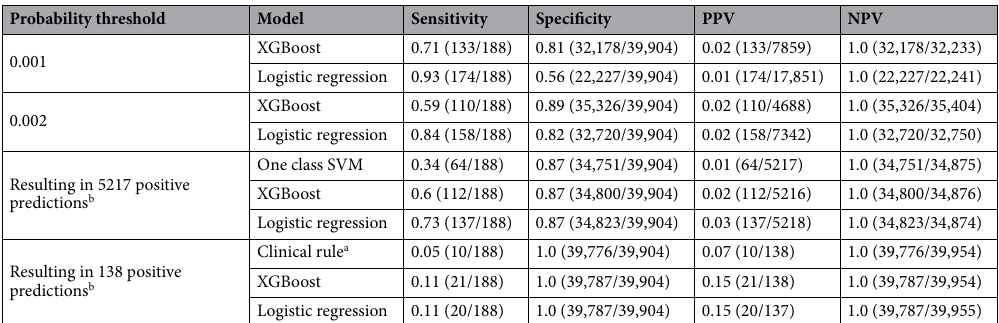
Probability threshold